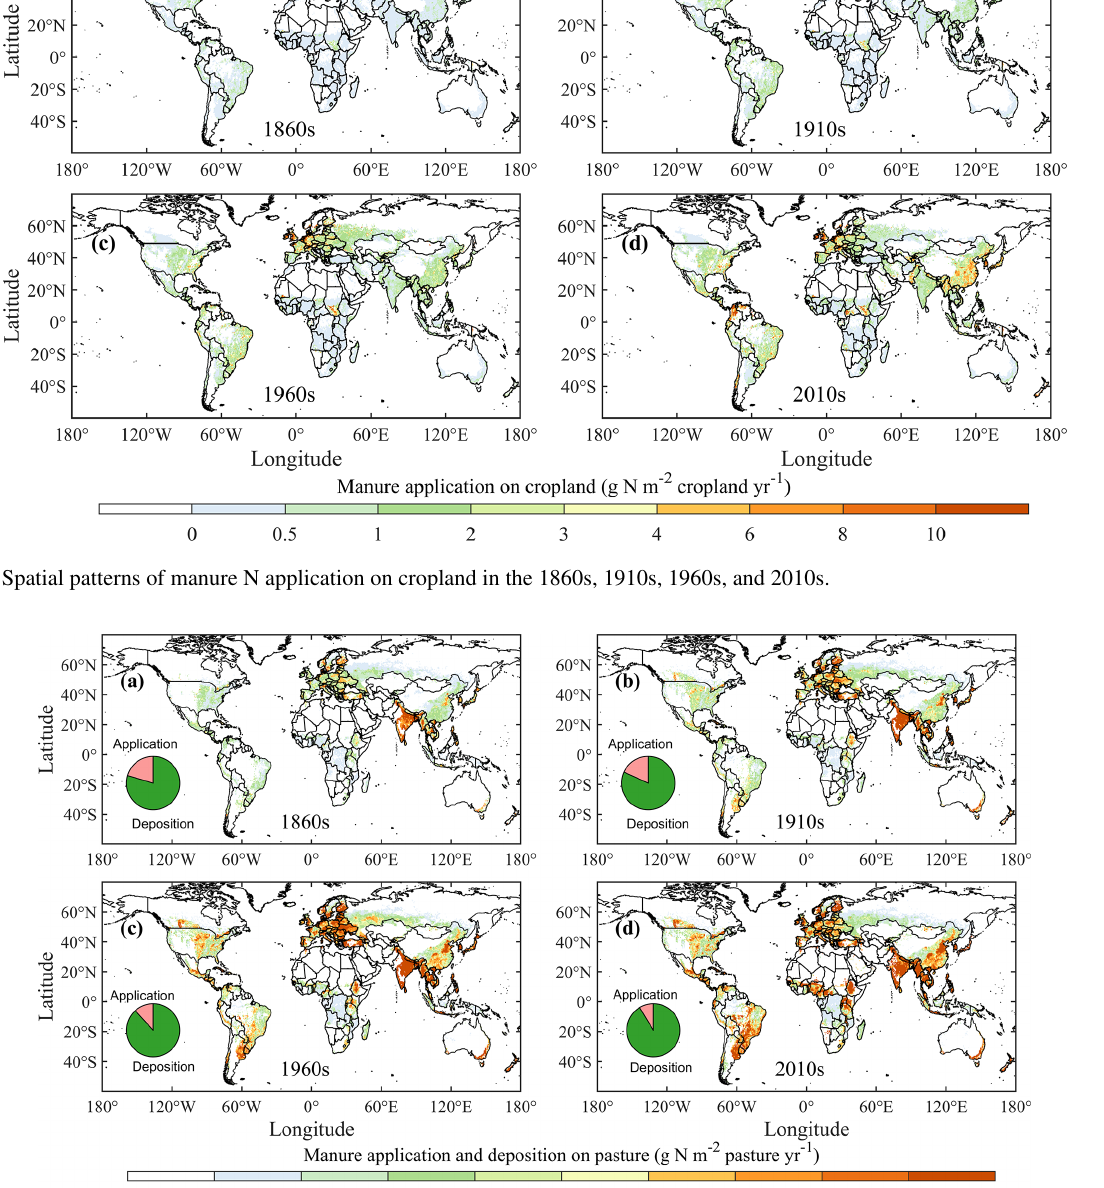
of 33.6 Tg yr − 1 in 2014 to 30.0 Tg yr − 1 in 2020. Crop